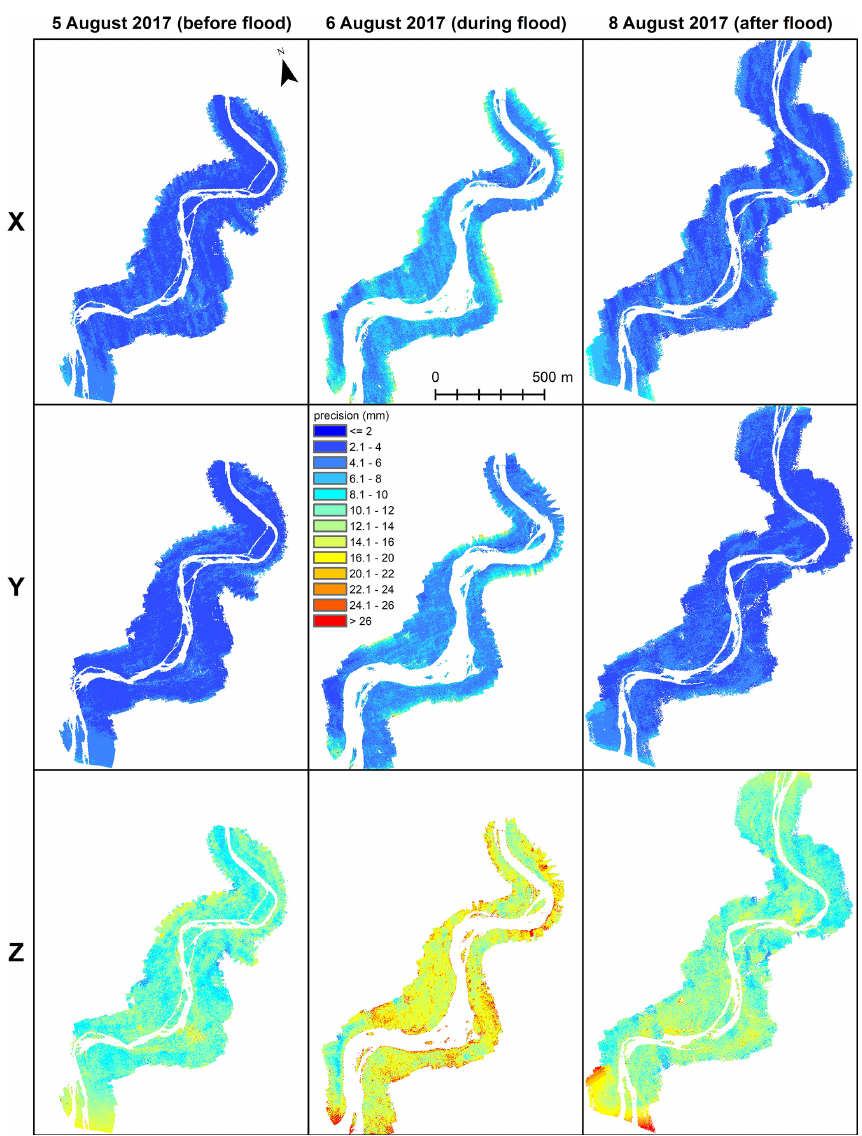
Figure 4. Precision estimates for X , Y , and Z coordinates of tie points. Location of the studied river section is presented in Fig.